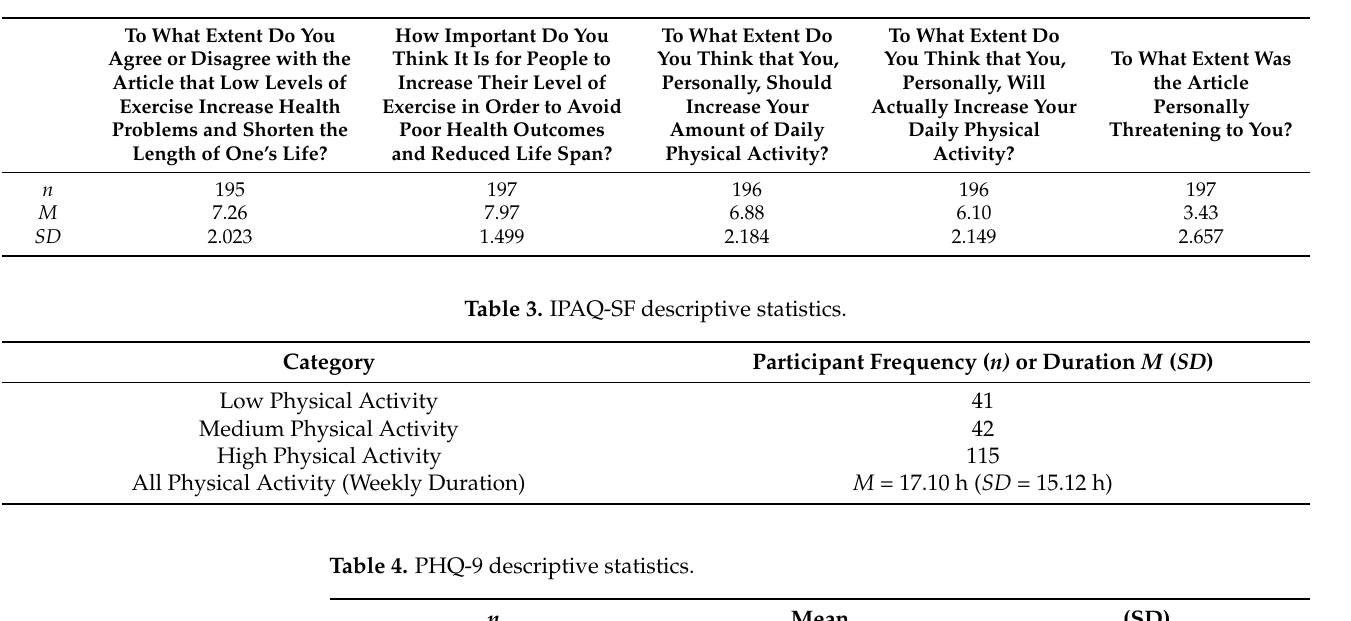
Table 2. Five-question survey descriptive statistics.